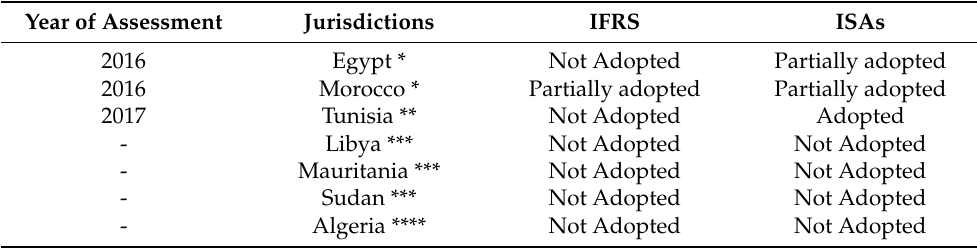
Table 1. Level of Adoption of IFRS and ISAs in North African Countries. Year of